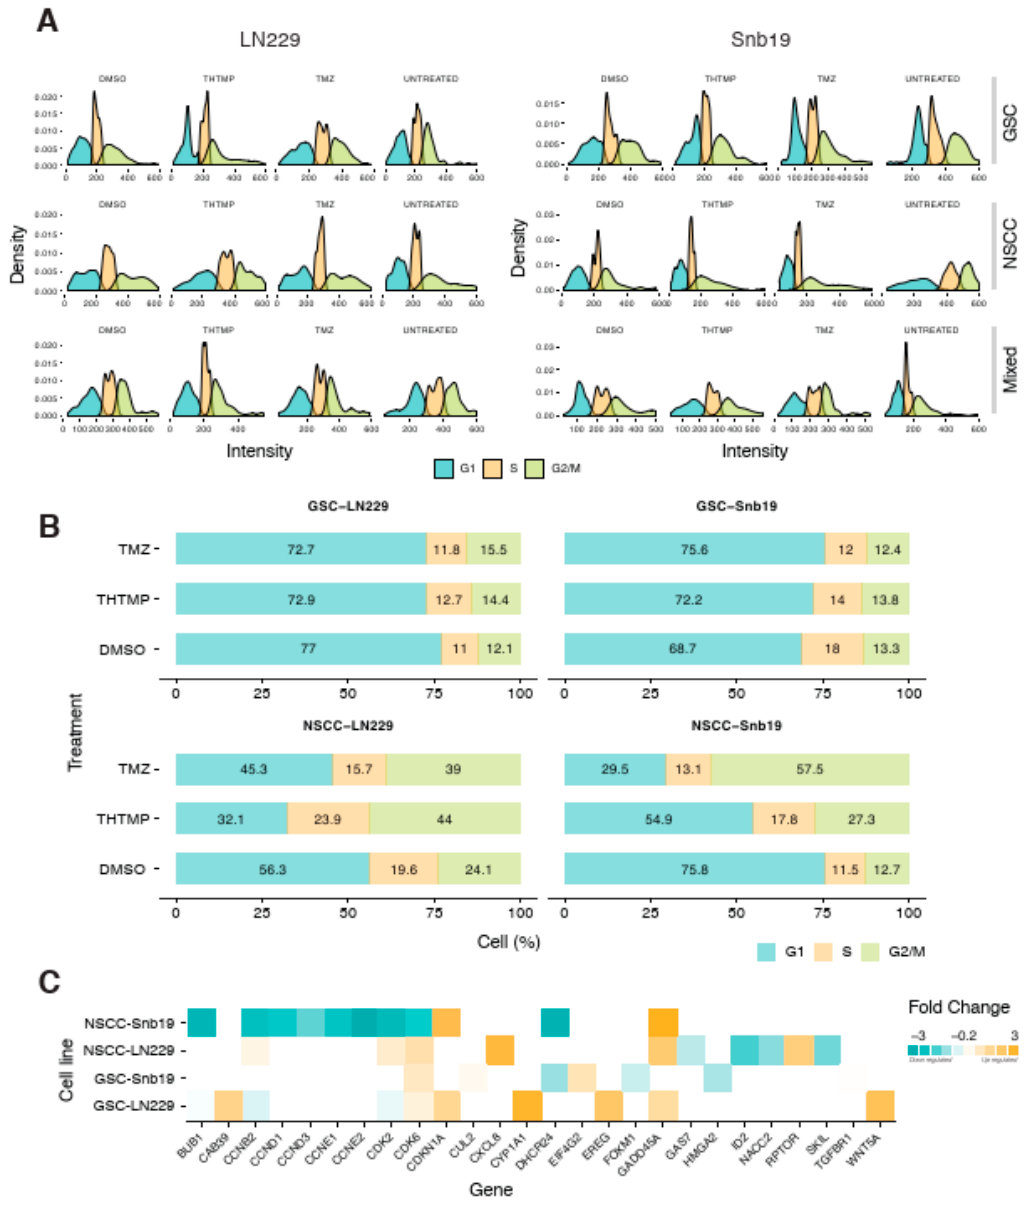
Figure 2. THTMP triggers GSC and NSCC cell cycle arrest. ( A ) Graphs represented the distribution of cells in di ff erent phases of cell cycle ( B ) The bar diagram representing the percentage of total cells in di ff erent cell cycle phases treated with THTMP / TMZ. ( C ) The top DEGs involved in the cell cycle in GSC and NSCC population. The DEGs were color coded corresponding to the up- and down- expressed genes. Five biological and technical repeats were used in cell cycle and gene expression analysis. All experiments were performed with N = 5.